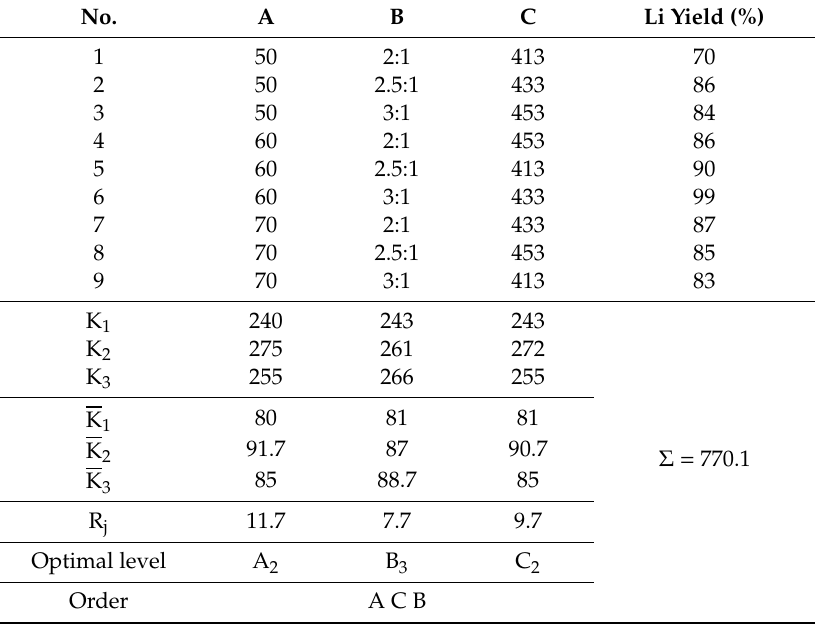
Table 5. The result of orthogonal experiment.